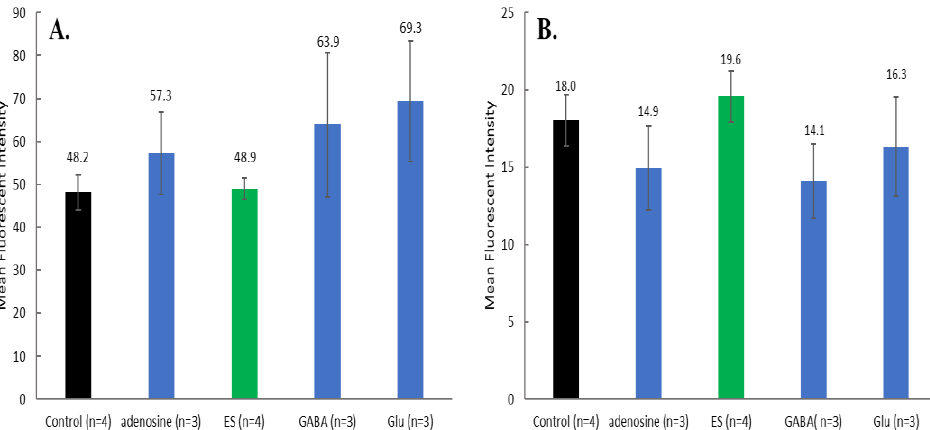
Figure 9. ( A ) Mean fluorescent intensity ± SD of Fluo-4 AM (Ca 2+ probe) averaged by condition group. All differences in mean intensities are significant except ES vs. Control by ANOVA with Tukey post hoc test ( p < 0.05). ( B ) Mean fluorescent intensity ± SD of MQAE (Cl − ) averaged by condition group. No statistical difference was found between any of the groups.